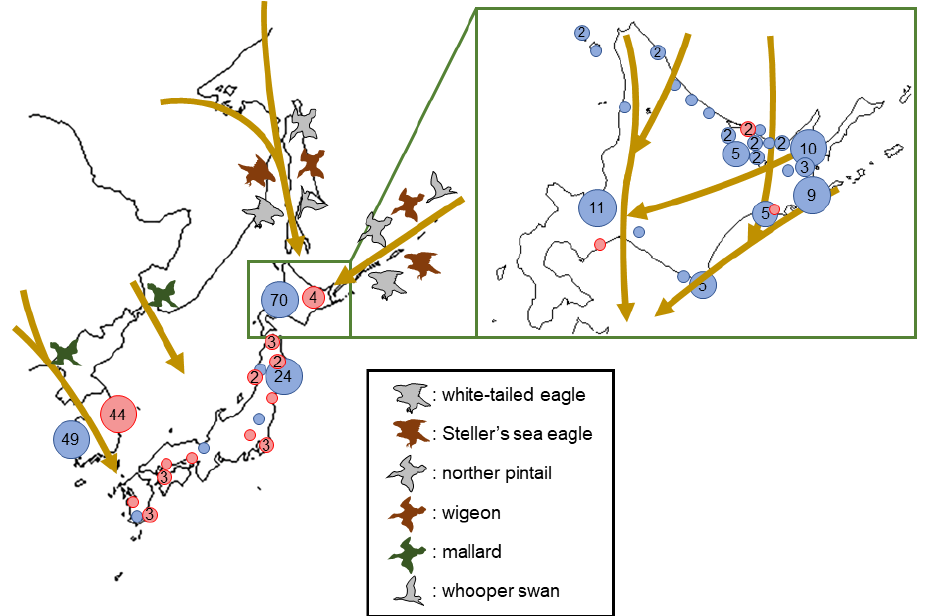
Figure 1. Number of high pathogenicity avian influenza (HPAI) outbreaks in poultry and cases in wild birds in the Far East between the beginning of November 2021 and the end of May 2022. Numbers in the circle indicate the reported accumulated numbers of HPAI outbreaks in poultry (red) and cases in wild birds (blue) in each area or country. A circle without a number indicates a single outbreak/case in the area. The yellow arrows indicate the general flyways of migratory birds in autumn-winter in Japan. Figures of colored structures indicate the migratory flyway of each migratory bird. Outbreak reports used in this figure were derived from the EMPRES-I +Global Animal Disease Information system (the Republic of Korea) [19], the HPAI outbreak database of the Ministry of Agriculture, Forestry and Fisheries [17], and the HPAI case database of the Ministry of Environment (Japan) [18].